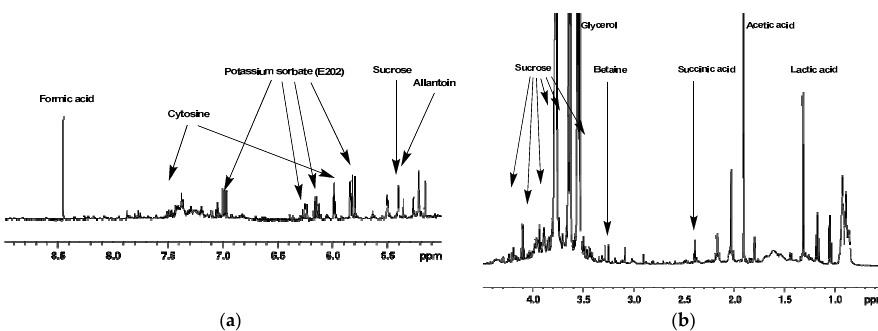
Figure 2. Typical 1 H-NMR spectrum of lyophilized mucus from Helix aspersa (<3 kDa) with assignment of the main metabolites. (1D-noesy experiment with water presaturation, pH = 7.35, 298.0 K). ( a ) 1 H-NMR spectrum in the interval from 5.0 to 9.0 ppm; ( b ) 1 H-NMR spectrum in the interval from 0.5 to 4.5 ppm.